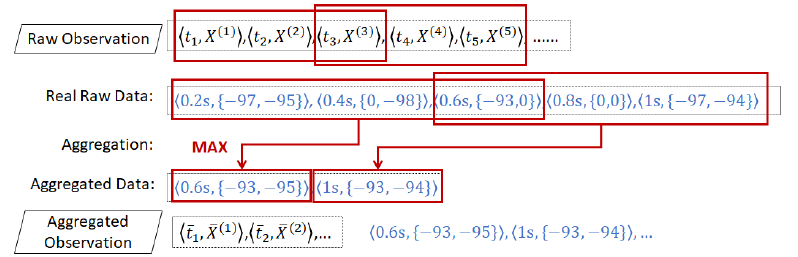
Figure 6. Performing aggregation from raw